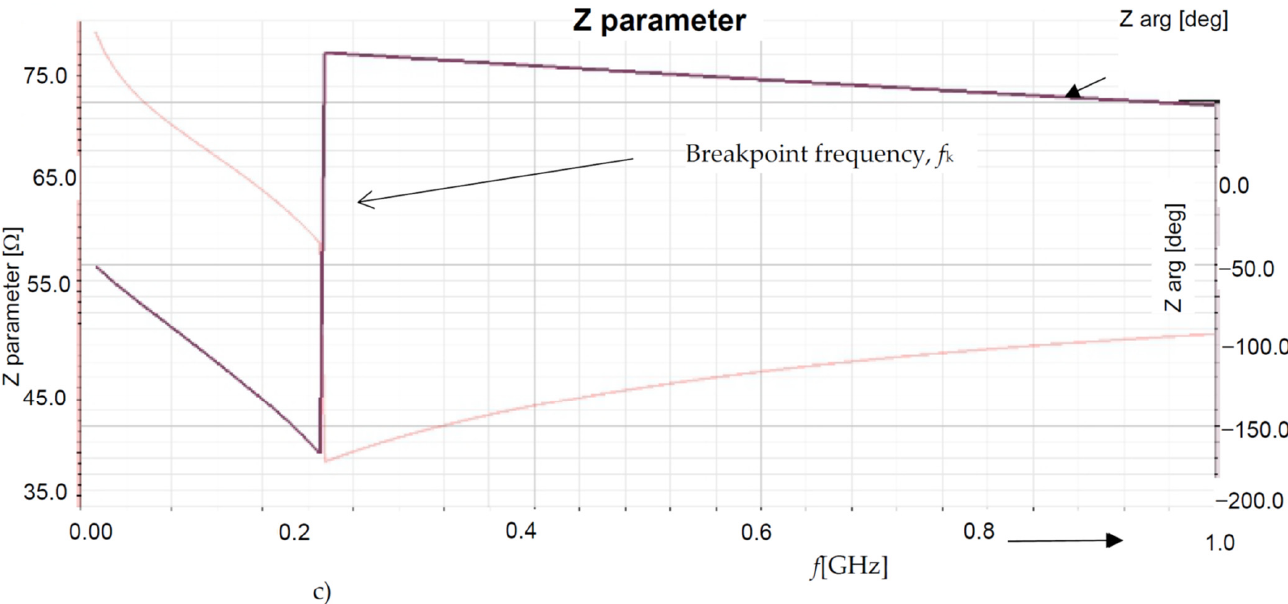
Figure 3. Analyzing and evaluating the geometrical arrangement of the plasma channel, single-turn electrode, external medium, and bottom metal plate: ( a ) parameter s 11mod , f = 10 MHz–1 GHz; ( b ) parameter z 11mod , f = 10 MHz–1 GHz; ( c ) parameter z 11arg , f = 10 MHz–1 GHz.